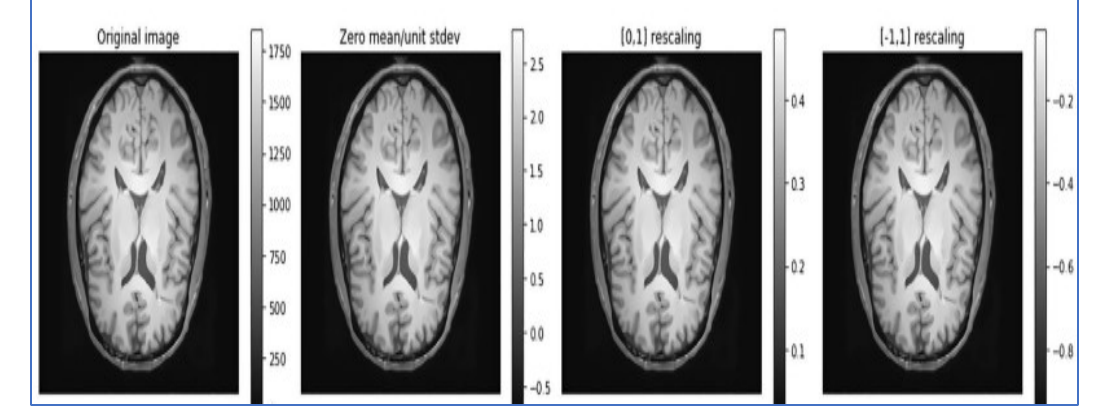
Figure 1. Example of resampling technique applied on MRI image [50,51].